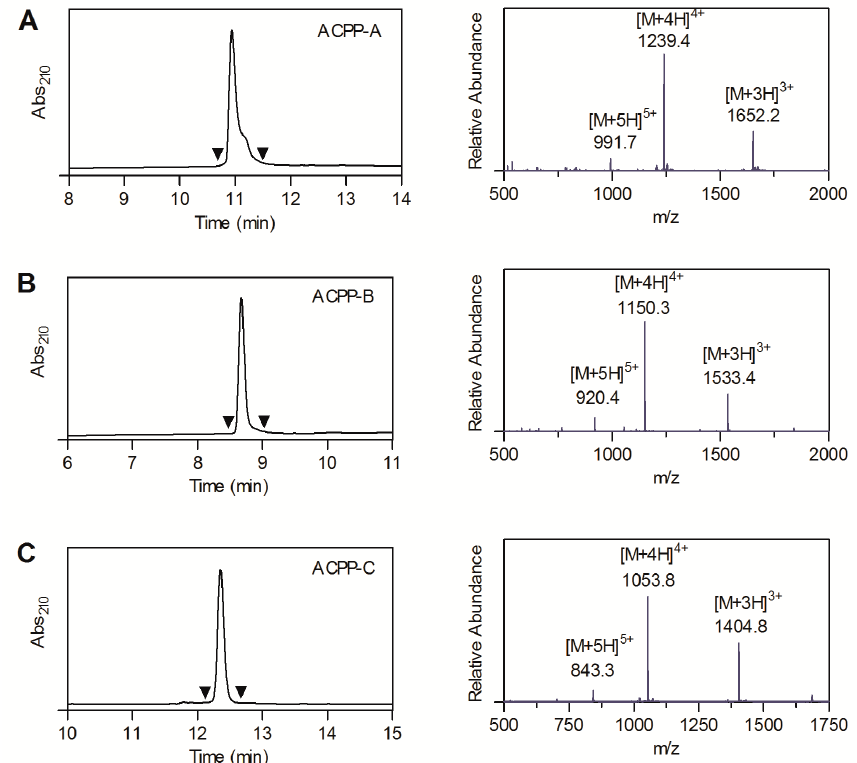
Figure 2. LC-MS characterization of ( A ) Ac-y-e 9 -X-C*PKESC*NLFVLKD-X-r 9 -dab(DOTA)- NH 2 (ACPP-A, obsd. 4951.4 Da, calcd. 4951.4 Da); ( B ) Ac-y-e 9 -X-CRPAHLRDSG-X-r 9